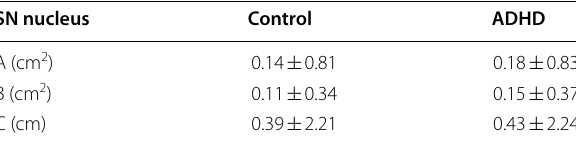
A: right nucleus area, B: left nucleus area, C: nucleus perimeter SN: substantia nigra , ADHD: Attention-Deficit/Hyperactivity Disorder